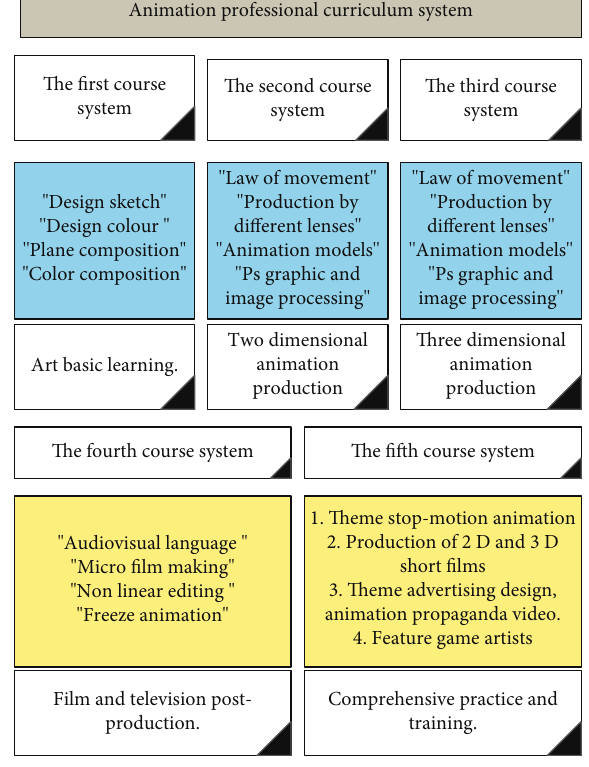
Figure 5: Construction diagram of the animation major curriculum